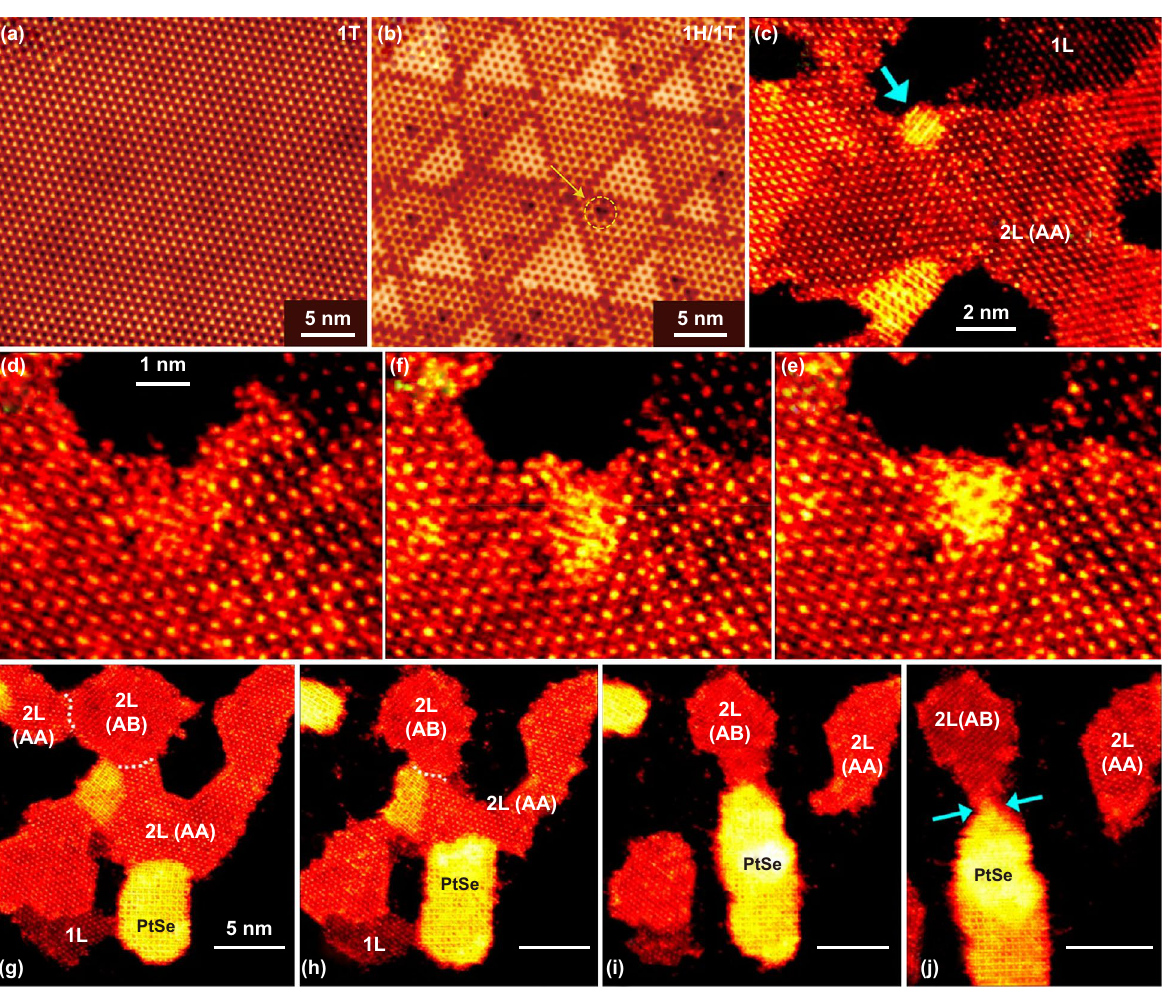
Fig. 4 In situ characterization of phase transitions of PtSe 2 . STM images of a 1T‑PtSe 2 and b 1H/1T patterned PtSe 2 . Reproduced with permis‑ sion [70]. Copyright 2017, Springer Nature. c PtSe 2 at the edge of bilayer PtSe 2 . d, e Successive annular dark field STEM images at a position indicated by a cyan arrow in ( c ). f Time between images ~ 60 s. g–j Successive annular dark field STEM images at the position indicated by cyan arrows in ( j ). White dashed line indicated the grain boundary. c–j Reproduced with permission [75]. Copyright 2019, American Chemical Soci‑